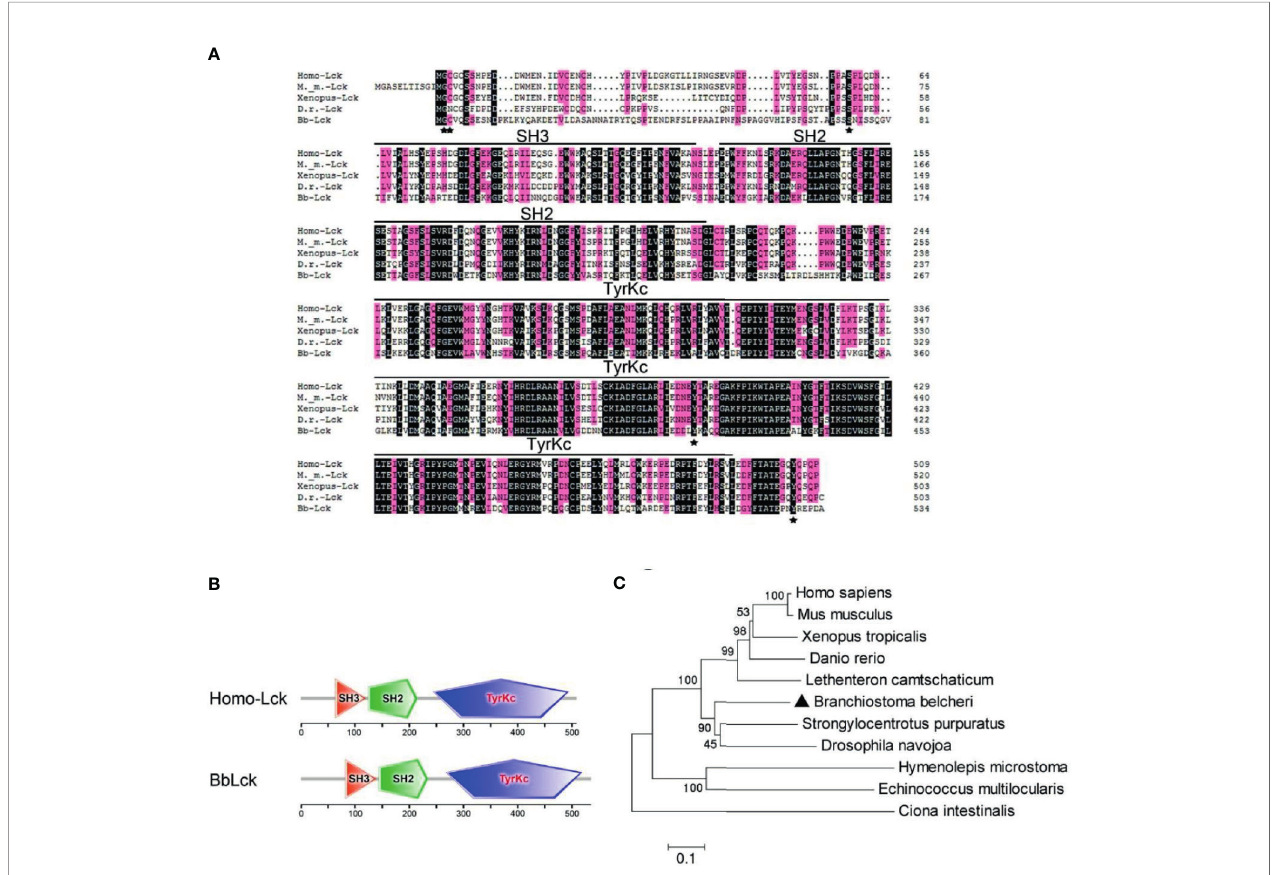
FIGURE 1 | The homology and phylogenetic analysis of Lck derived from different species. (A) The similarities between Lck protein sequences determined by Clustal 8.0. (B) Domain comparison of Homo-Lck and BbLck using the sequence analysis tool SMART. (C) Phylogenetic tree of Lck sequences. T neighbor-joining phylogenetic tree was constructed by Mega5.0 on the basis of eleven different Lck sequences from GenBank. The accession numbers of the Lck sequences used in (A – C) are as follows: Homo sapiens Lck (GenBank, NP_001036236.1), Mus musculus Lck (GenBank, NP_001155904.1), Xenopus tropicalis Lck (GenBank, XP_012812855.2), Danio rerio Lck (GenBank, NP_001001596.1), Ciona intestinalis Lck (GenBank, XP_002123919.1), Strongylocentrotus purpuratus Lck (GenBank, NP_999783.1), Drosophila navojoa Lck (GenBank, XP_017960855.1), Hymenolepis microstoma Lck (GenBank, CDS29567.1), Echinococcus multilocularis Lck (GenBank, CUT99347.1); and Lethenteron camtschaticum Lck (GenBank,